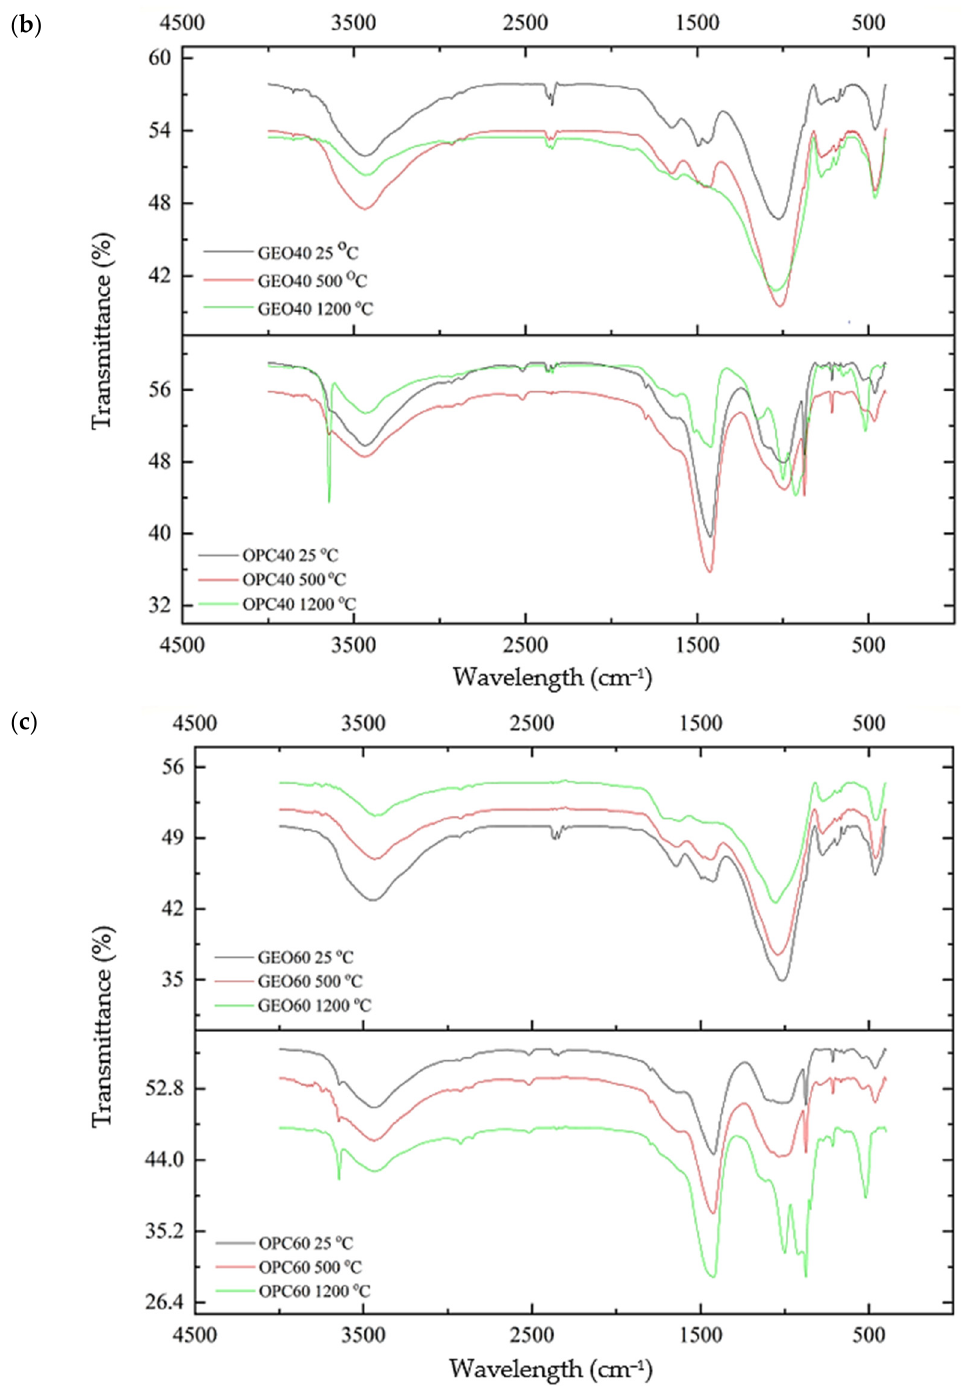
Figure 7. FTIR spectra of OPC-based and geopolymer concrete specimens of standard strength grades of ( a ) 20 MPa, ( b ) 40 MPa, and ( c ) 60 MPa.